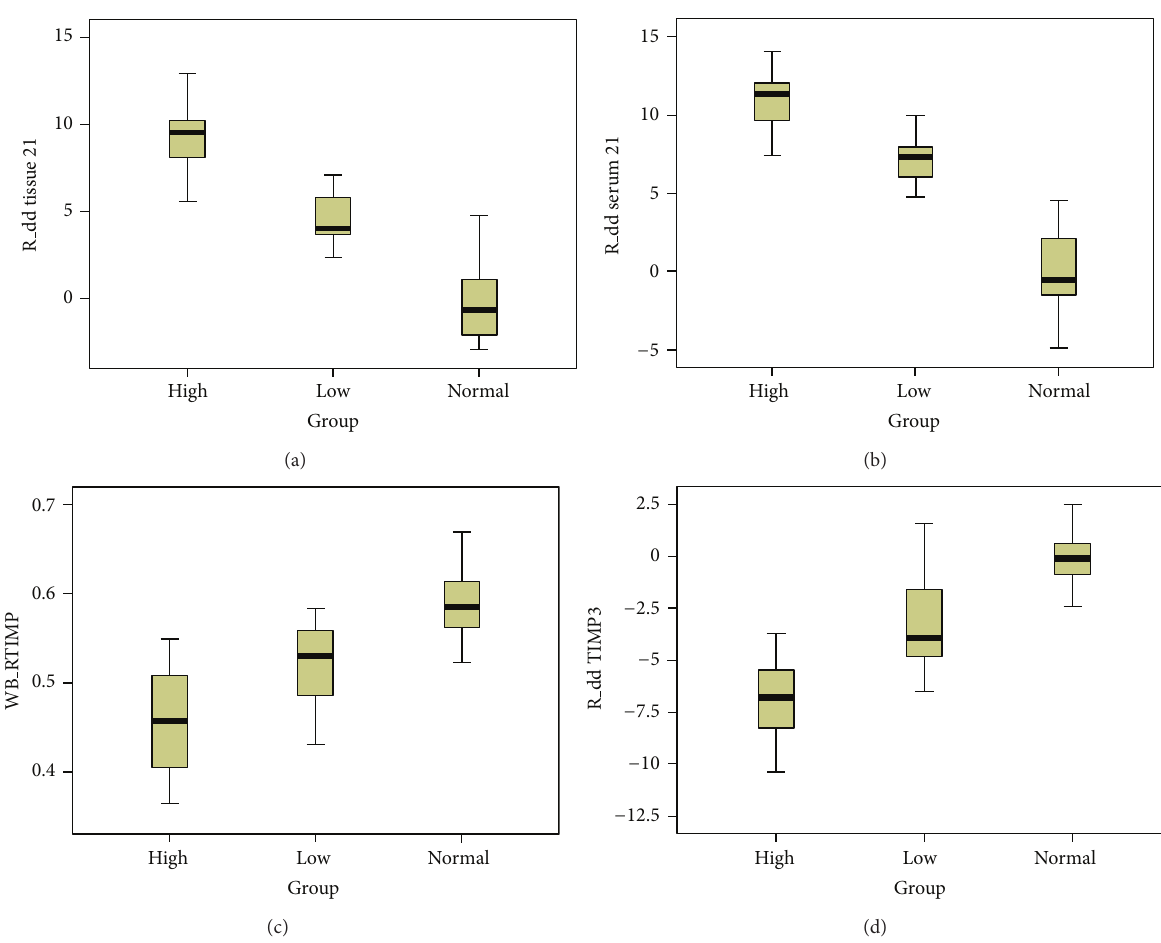
Figure 2: (a) miR-21 in various clinical invasions in breast cancer tissue of the different transcripts. Experimental method: realtime RT-PCR; statistical method: ANOVA showed P < 0.05; comparison between groups P < 0.05, that is, HIMG > LIMG > NG. (b) miR-21 in various clinical invasions in breast cancer patients serum of the different levels. Experimental method: realtime RT-PCR; statistical method: ANOVA showed P < 0.05; comparison between groups P < 0.05, that is, HIMG > LIMG > NG. (c) TIMP3 in various clinical invasions in breast tissue of different expressions. Experimental methods: western blot; statistical method: ANOVA showed P < 0.05; comparison between groups P < 0.05, HIMG < LIMG < NG. (d) TIMP3 in various 𝑡 clinical invasions in breast cancer tissue of the different transcripts. Experimental